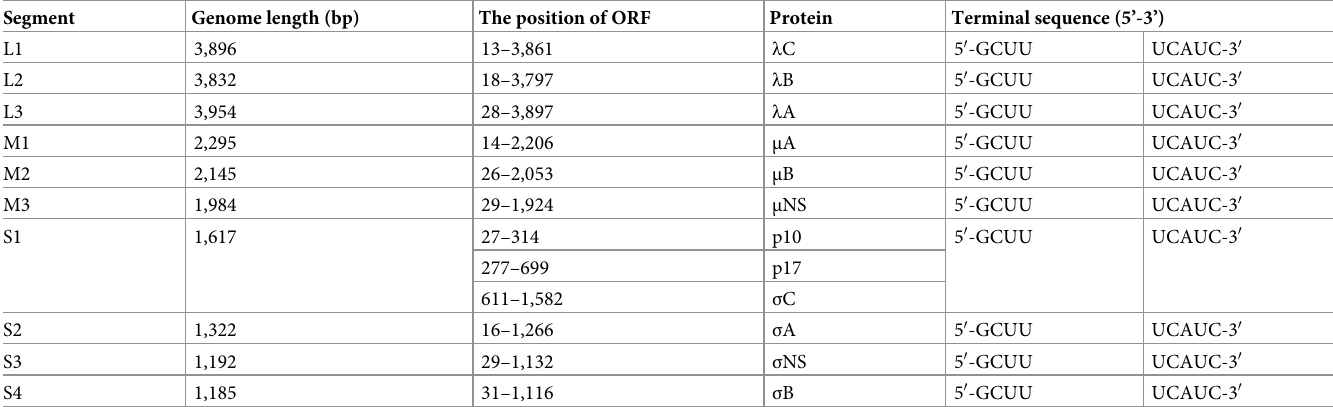
Table 2. Genome organization of Nachunsulwe-57. Segment